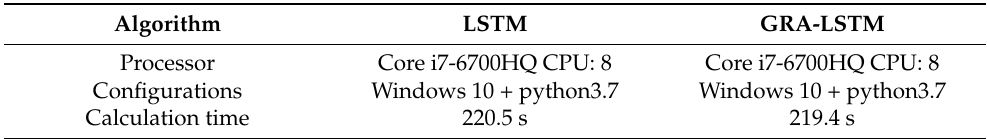
Figure 6. Water quality predictions and their comparisons with original data. (a) DO; (b) COD; (c) TP; (d) pH; (e) NH 3 -N. Table 3. Hardware and software